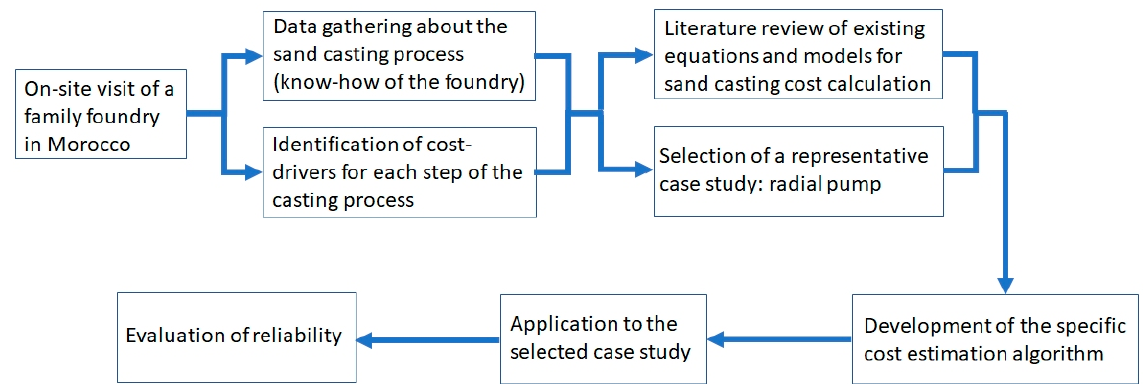
Figure 1. Schematic diagram of the research methodology followed.